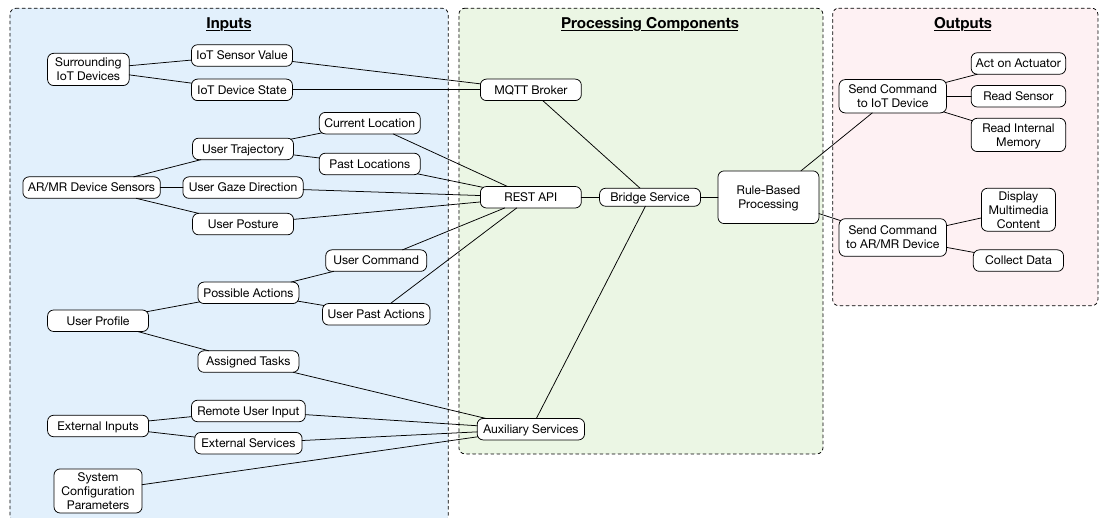
Figure 2. Component model of the proposed